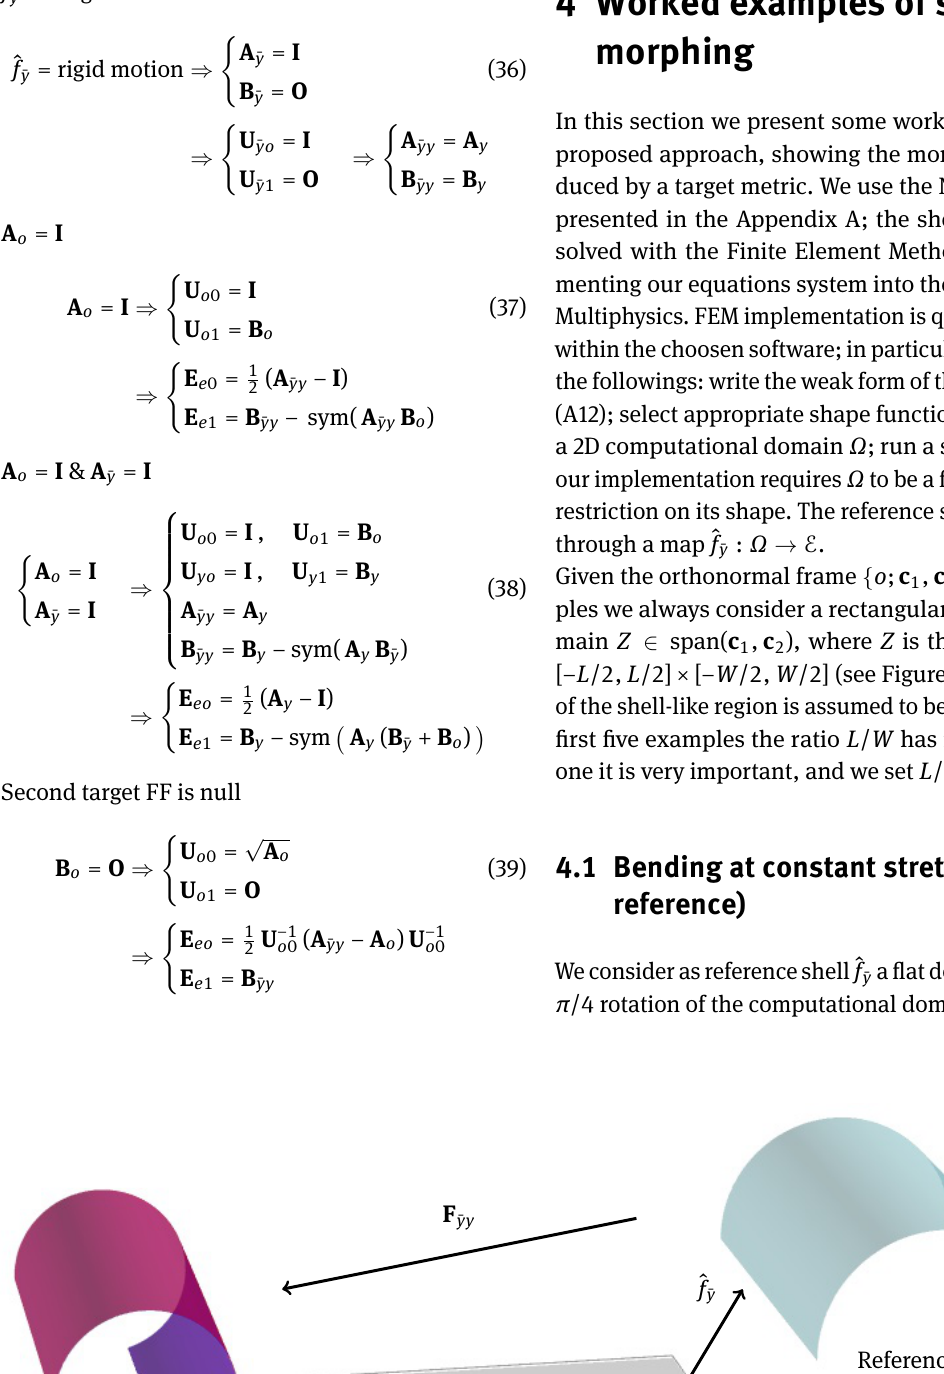
is the deformation of ^ f with respect to ^ f ¯ y yy y